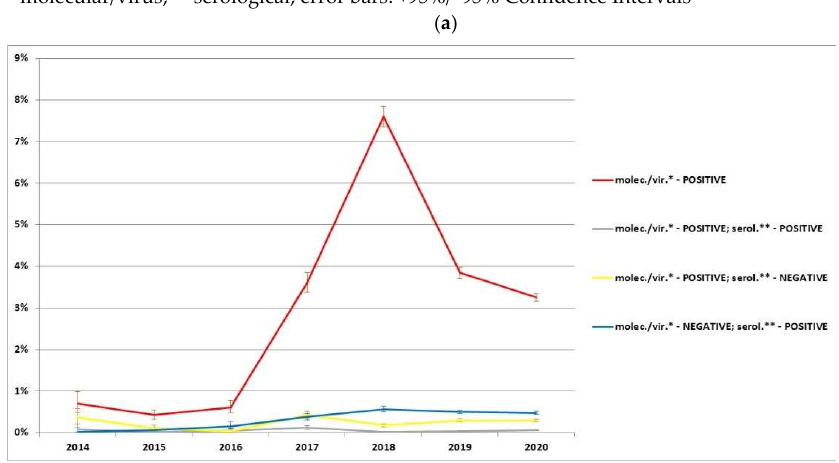
Figure 2. Wild boars tested for the presence of ASFV and/or antibodies against ASFV in Poland in the years 2014–2020: ( a ) percentage division of all analyzed wild boars; ( b ) percentage division of analyzed wild boars without ASF-negative animals.